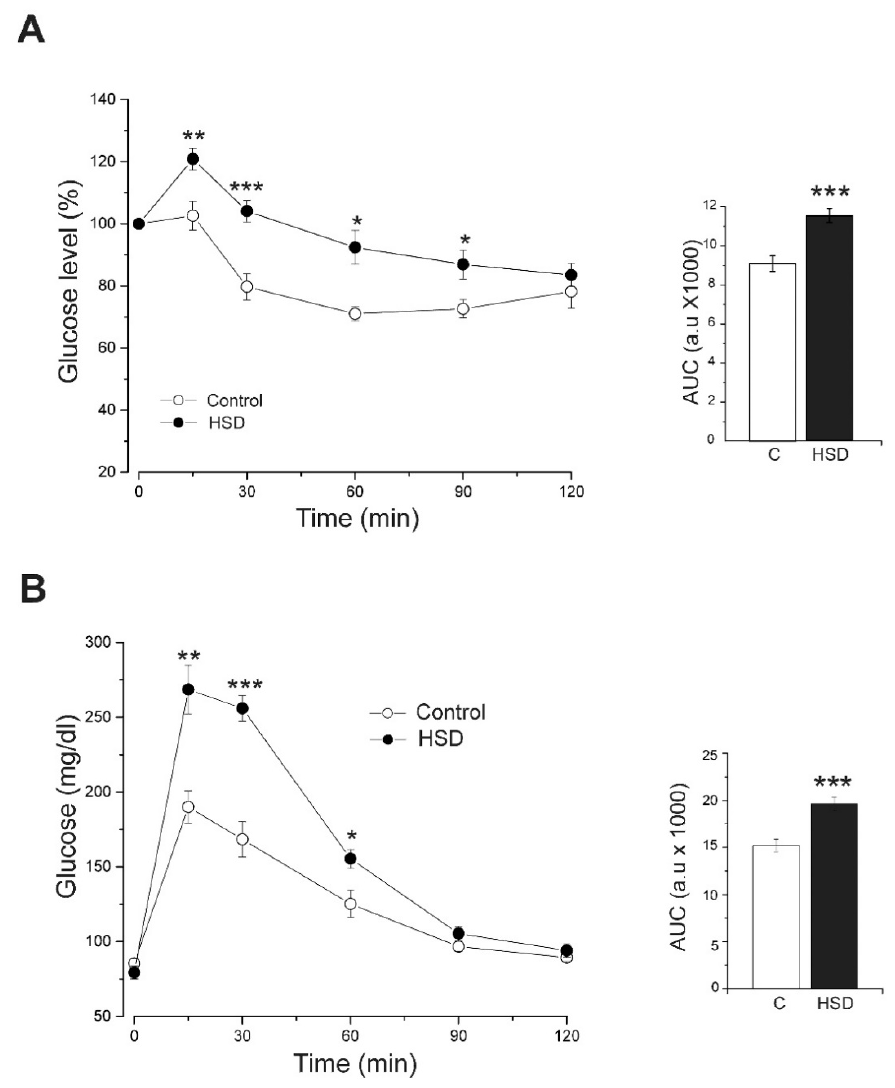
Figure 3. High-sucrose diet induces insulin resistance. ( A ) Left panel, insulin tolerance test performed on fasted overnight control rats ( n = 13) and HSD rats ( n = 13). Data expressed as mean ± SE. One-way ANOVA was performed with post hoc Tukey’s test, * p < 0.05, ** p < 0.01, *** p < 0.001 compared to the control group. Right panel, the area under the curve. Bars represent the mean ± SE, *** p < 0.001 compared to control group. ( B ) Left panel, intraperitoneal glucose tolerance tests were performed on control ( n = 21) and HSD ( n = 14) rats. Data expressed as mean ± SE. One-way ANOVA was performed with post hoc Tukey’s test, * p < 0.05, ** p < 0.01, *** p < 0.0001 compared to the control group. Right panel, the area under the curve. Bars represent the mean ± SE, * p < 0.05 compared to the control